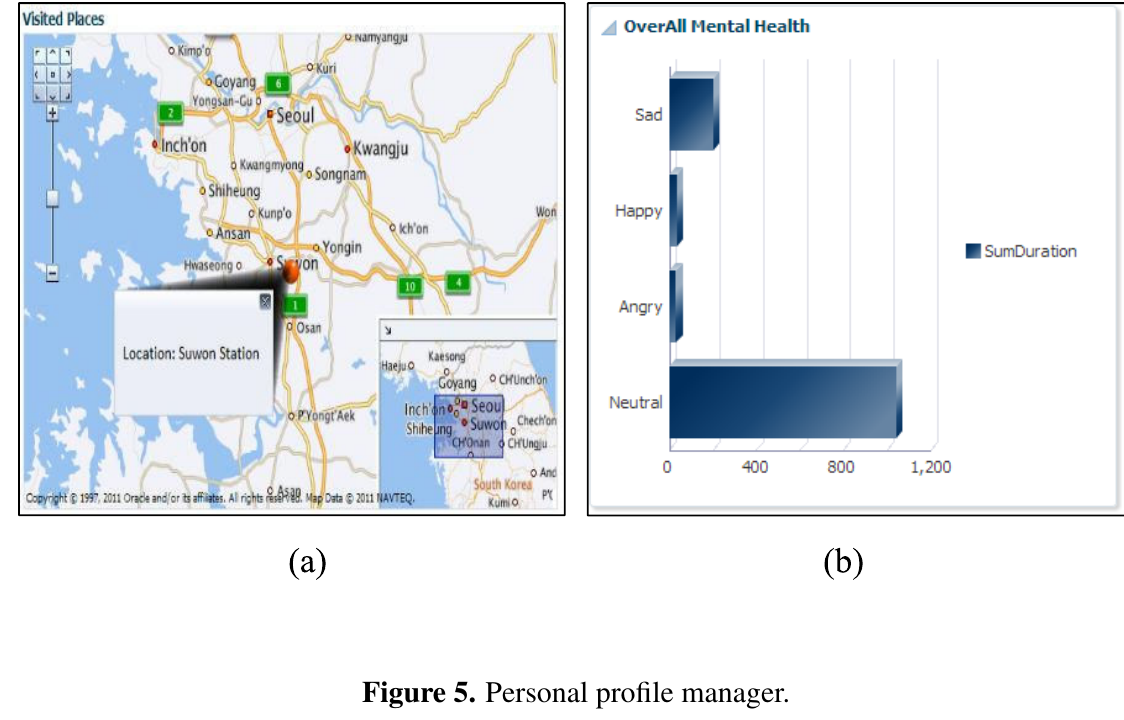
Figure 4. Health primitive social interaction and mental health visualization.